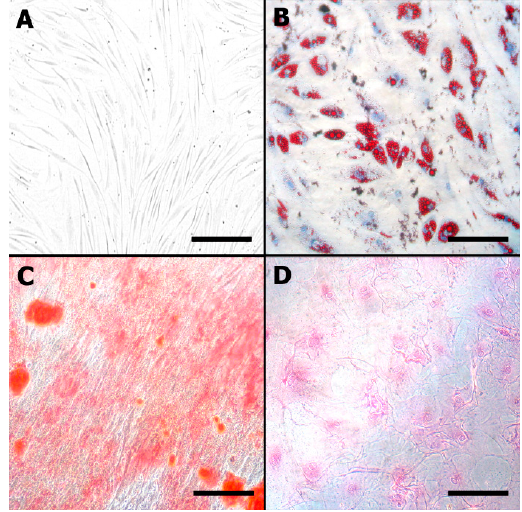
Figure 2. Characterization of the isolated AT-MSCs (objective, ×10): ( A ) Spindle-shaped morphology on light microscopy; ( B ) AT-MSC differentiation into the adipogenic cell lineage (Oil Red O); ( C ) osteogenic cell lineage (Alizarin red); and ( D ) chondrogenic cell lineage (Sirius red, resorcin and fuchsine). Scale bars represent 100 μ m.